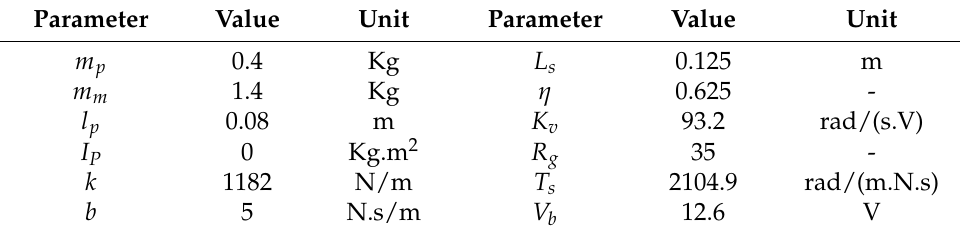
Table A1. Basketball Robot